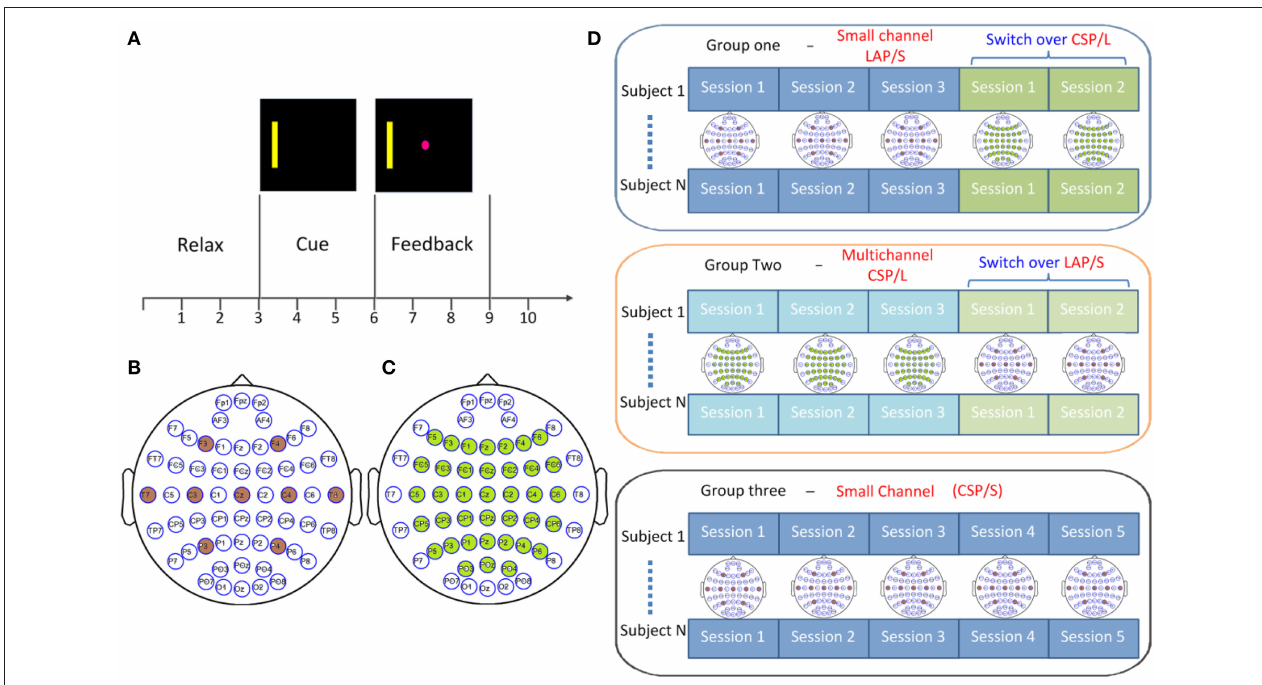
FIGURE 1 | Experimental design. (A) Trial structure for cursor movement BCI control using left- and right-hand motor imagery. (B) Small channel configuration for large Laplacian filtering (LAP/S) method. (C) Multichannel configuration with 40 electrodes decoded by common spatial filter (CSP/L) method. (D) Switch-over design for the first two groups where participants were randomly distributed into two groups: each group performed three sessions of the original configuration and associated decoding method and then switched over to the other for the remaining two sessions; the channel configuration for each session is shown accordingly. Subjects in group three performed five sessions of online decoding by CSP/S but via the small channel configuration indicated in (B)